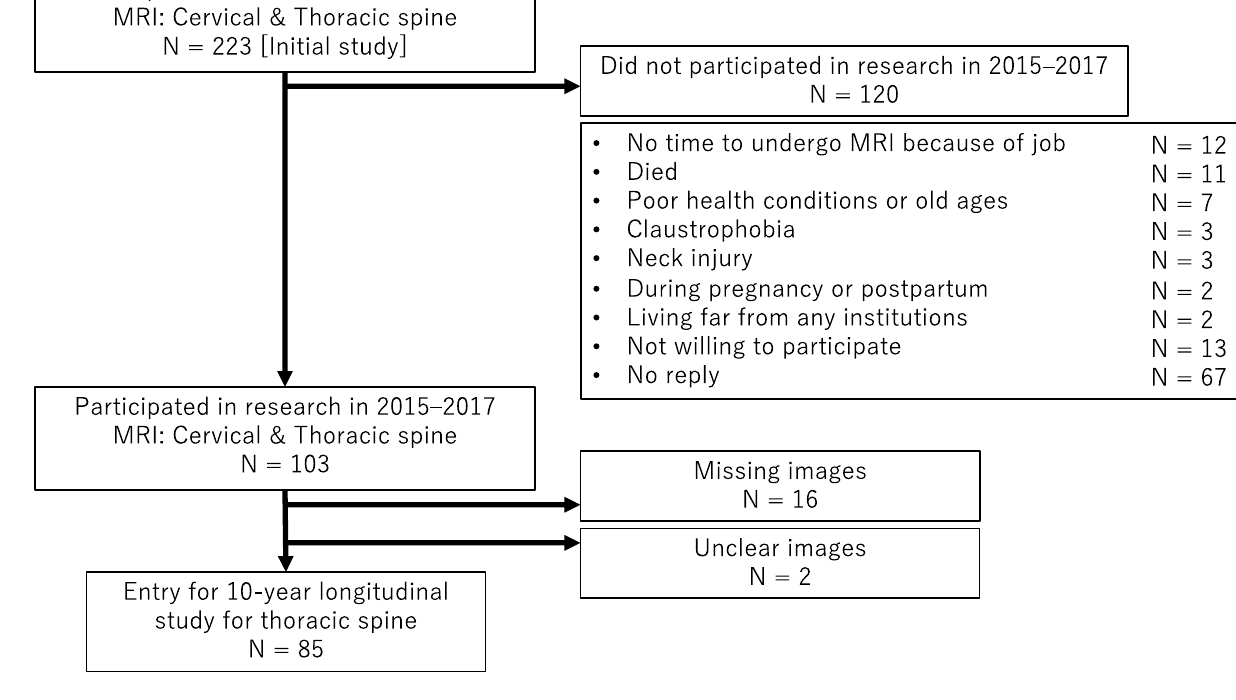
Figure 1. Study design. This study evaluated the 10-year longitudinal changes of the paravertebral muscles in the thoracic spine and was conducted as part of a 20-year longitudinal study of the cervical